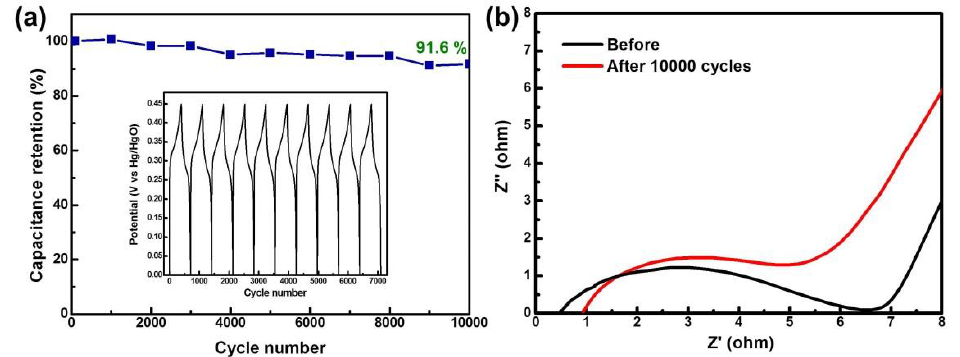
Figure 6. ( a ) Cyclic stability of the NiCo 2 S 4 / Ni-rGO nanocomposites at a current density of 1.0 A · g − 1 ; ( b ) Nyquist plots of the NiCo 2 S 4 / Ni-rGO nanocomposites before and after cycling of 10,000 cycles.